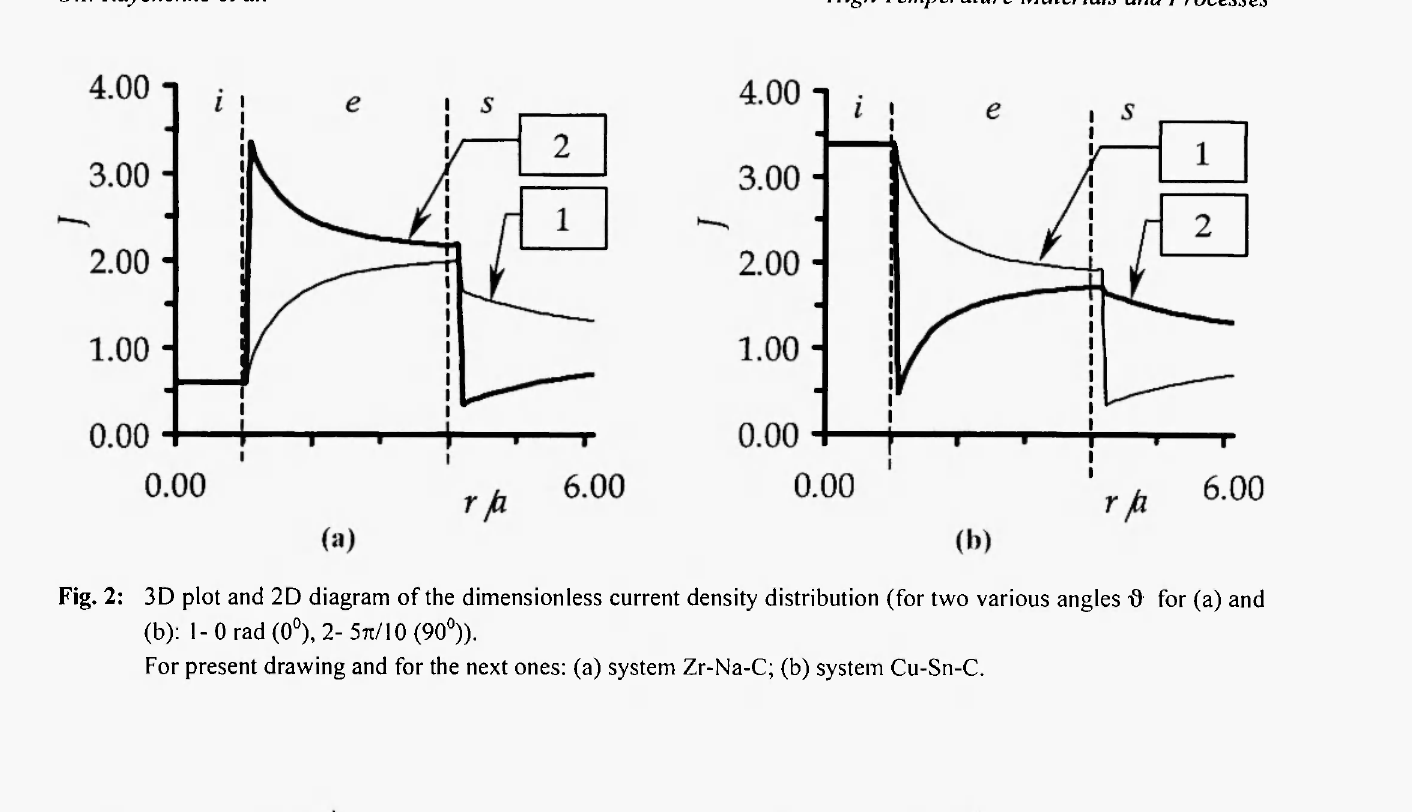
Fig. 2: 3D plot and 2D diagram of the dimensionless current density distribution (for two various angles ϋ for (a) and (b): 1- 0 rad (0°), 2- 5π/10 (90°)). For present drawing and for the next ones: (a) system Zr-Na-C; (b) system